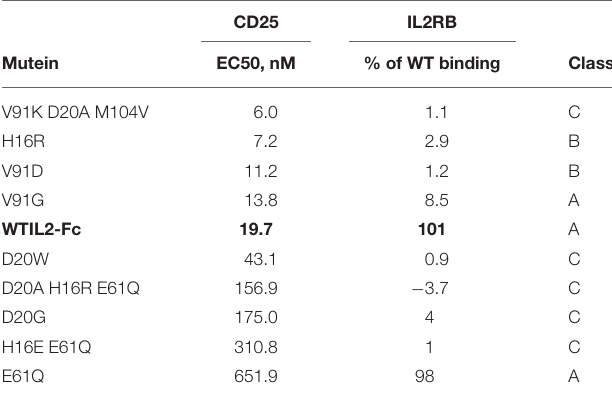
TABLE 2 | Relative binding affinity of IL-2 muteins to CD25 and